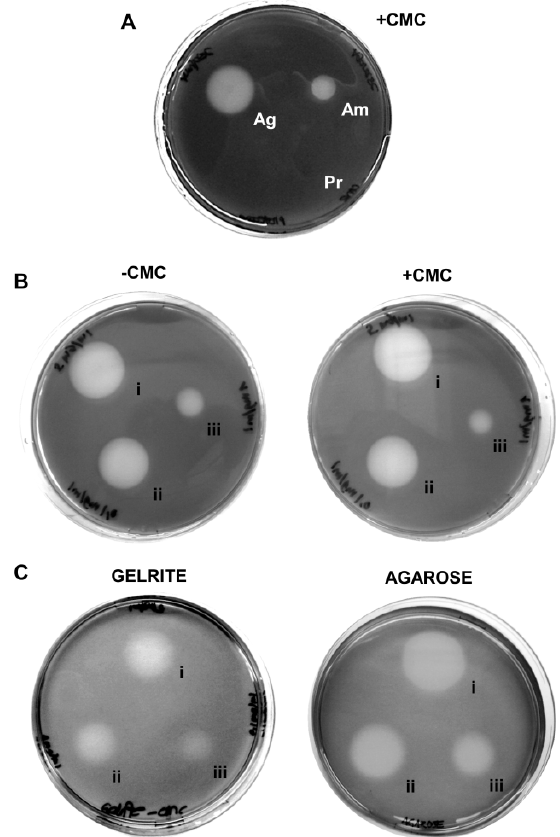
unwanted artifacts. ( A ) Unspecific halo occurrence with non-cellulolytic enzymes: 5 μ g agarase (Ag), 5 μ g amylase (Am) and 5 μ g proteinase K (Pr) were spotted onto 1% agar with 0.2% CMC and stained with Gram’s iodine solution after incubation. Halos are visible around both agarase and amylase; ( B ) Unspecific halo occurrence in the absence of the substrate: 25 μ g (i), 5 μ g (ii) and 0 μ g (iii) cellulase from Aspergillus niger were spotted onto agar with and without 0.2% CMC as cellulolytic substrate and detected by Gram’s iodine. Halo formation of comparable extent independent of the CMC can be seen; and ( C ) Unspecific halo occurrence on other gelling agents: Cellulase in the same concentrations as in ( B ) was spotted onto plates containing 0.2% CMC in 1% agarose or in 0.75% Gelrite and detected by Gram’s iodine. Halos are more diffuse than on agar, but can be clearly